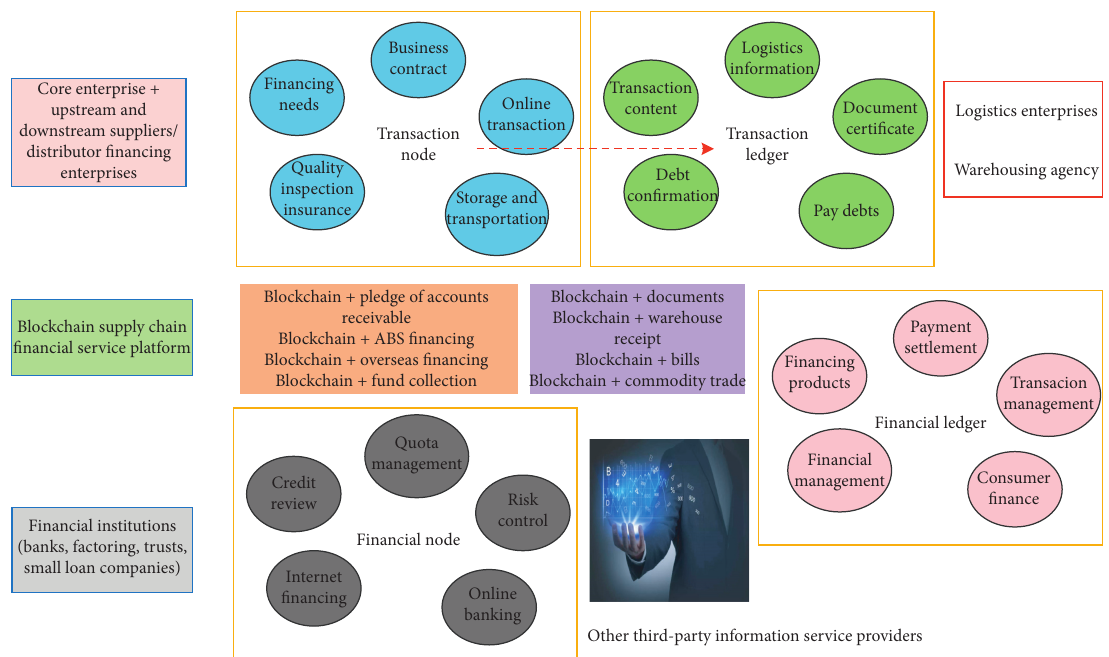
Figure 4: Schematic diagram of the application system of the supply chain financial platform under the blockchain